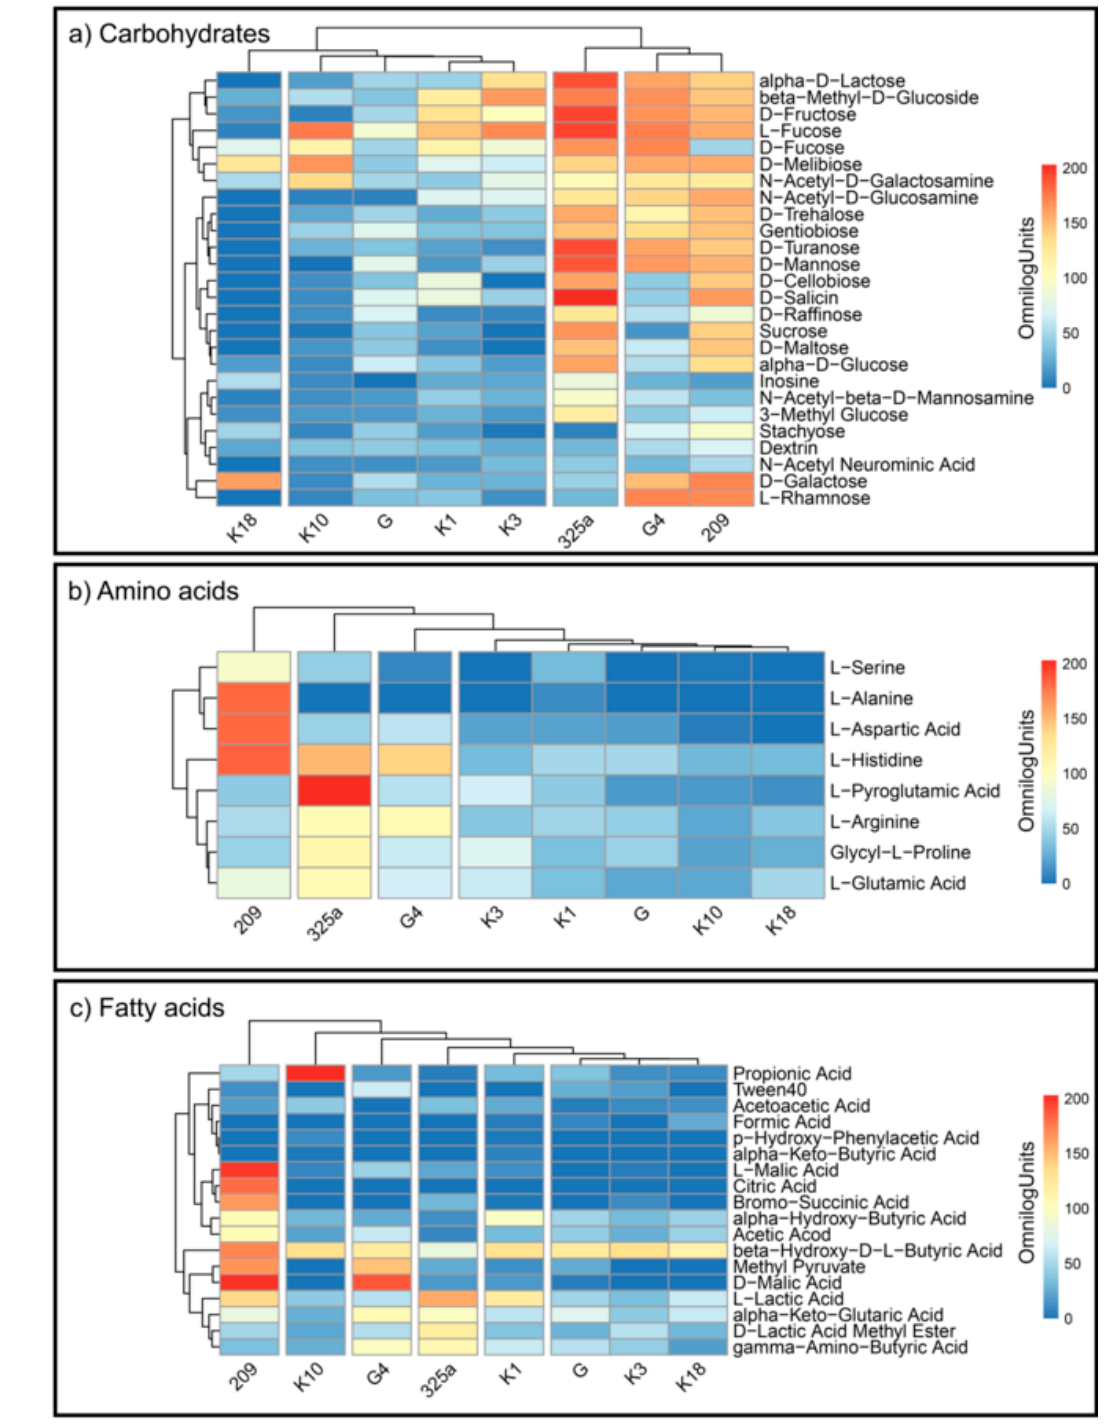
Figure 4. Heatmaps for the carbon utilization patterns of the substrates on GEN III™ grouped into three biochemical groups: ( a ) carbohydrates, ( b ) amino acids, and ( c ) fatty acids, by each strain of R. leguminosarum . Data are shown after 168 h of incubation. The gradient from light blue to red represents positive utilization.